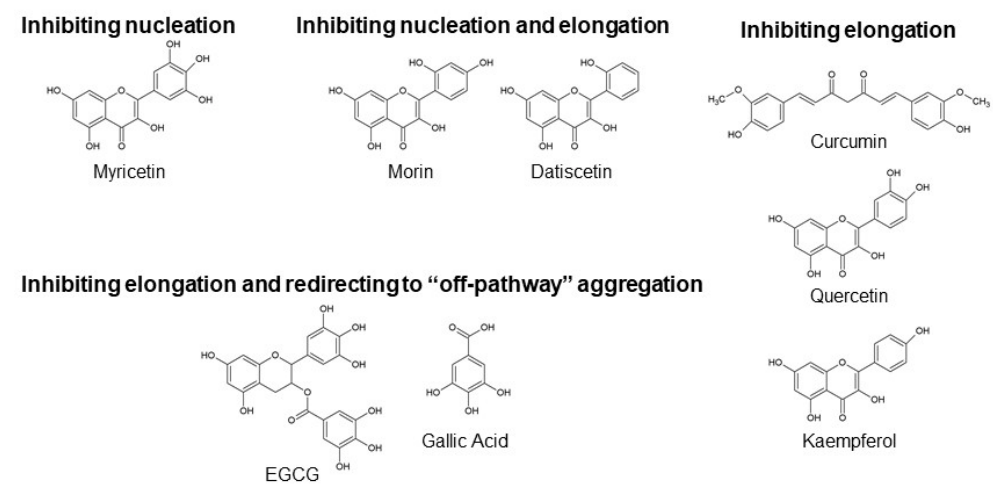
Figure 2. Chemical structures of polyphenols shown in Table 1. EGCG: epigallocatechin gallate